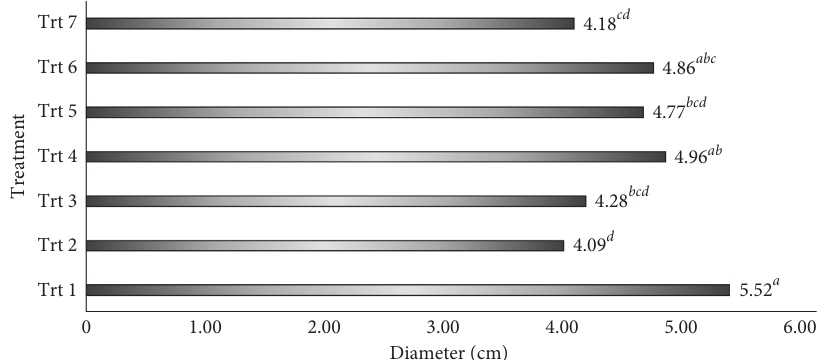
Figure 1: Graph showing the average cap diameter for mushrooms grown using different substrate combinations.